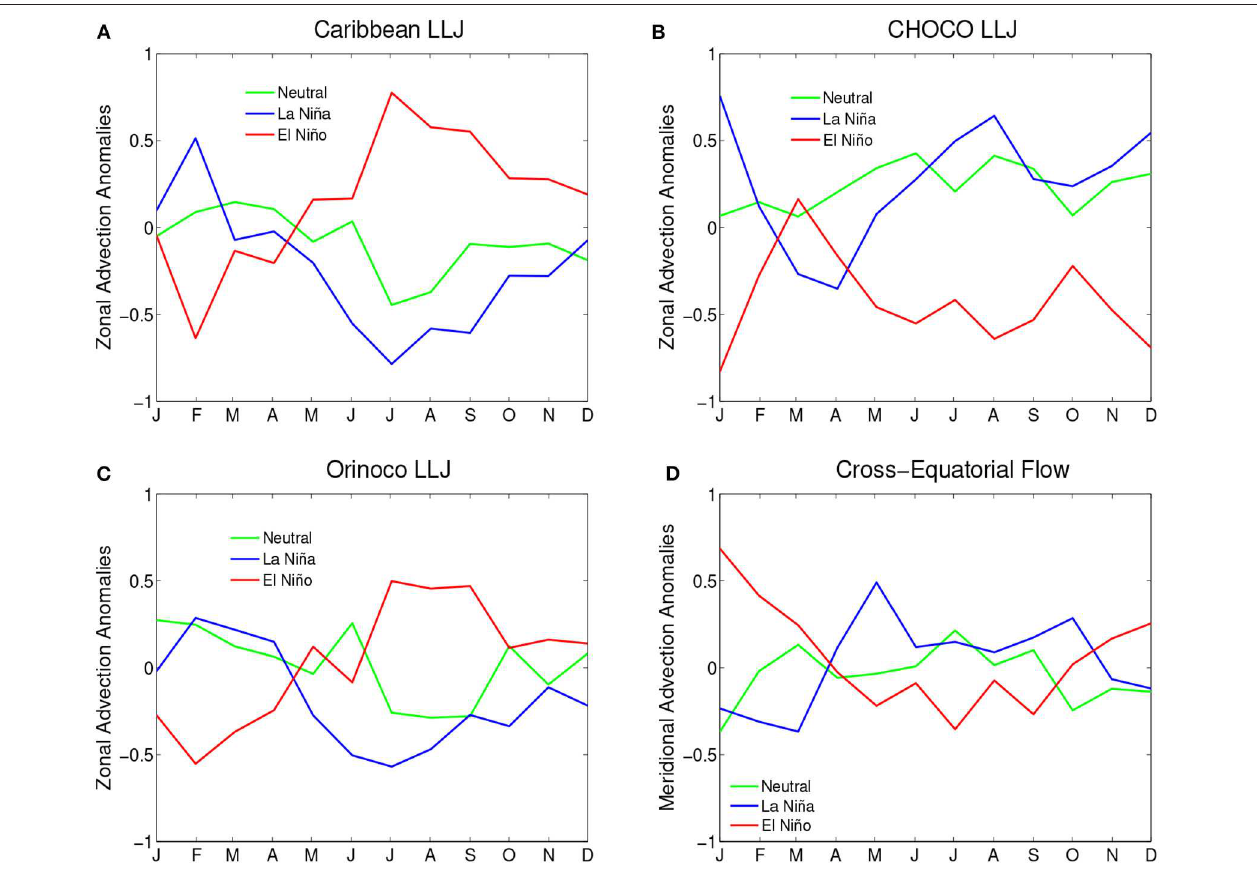
FIGURE 6 | Annual cycle of standardized moisture advection anomalies during ENSO using data from the NCEP/NCAR Reanalysis Project for the period 1970–2015. (A) Zonal moisture advection by the Caribbean LLJ. (B) Zonal moisture advection anomalies by the CHOCO LLJ. (C) Zonal moisture advection anomalies by the Orinoco LLJ. (D) Meridional moisture advection by the Cross-Equatorial Flow.